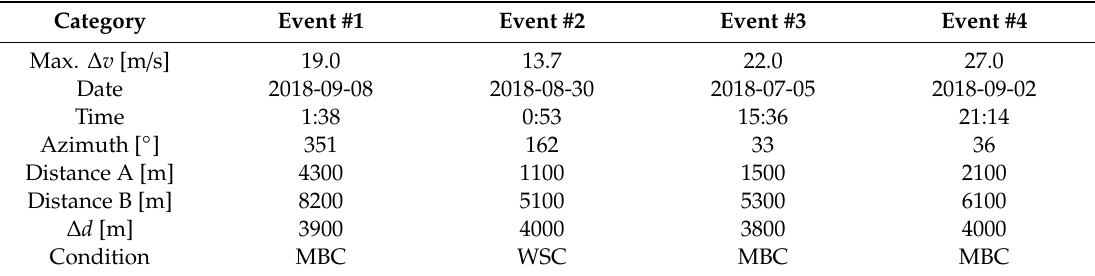
Table 4. Evaluation of the selected weather events (#1 − #4) in the aspect of wind shear severity: the maximum di ff erence in wind speed (Max. ∆ v ) along a distance of 4 km or less, with the exact time and location of their occurrence. WSC = wind shear condition, MBC = microburst